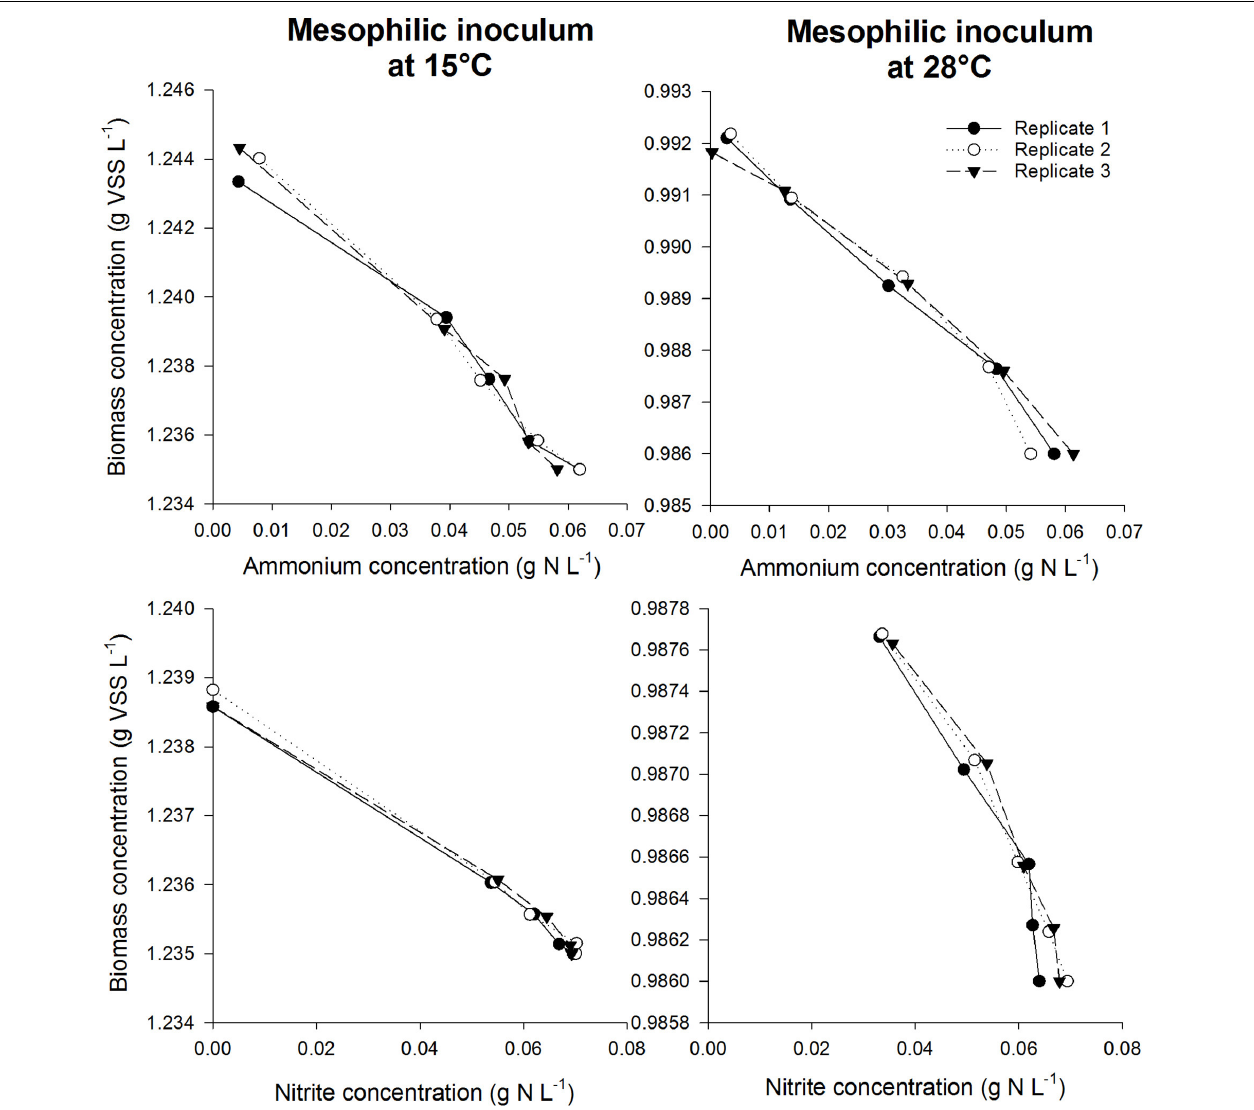
FIGURE 4 | Biomass concentration as a function of ammonium concentration (top) or nitrite concentration (bottom) during the incubations for the mesophilic inoculum at 15 ◦ C (left) and 28 ◦ C (right). The slope was used to determine the biomass yield for NOB in case nitrite was added as substrate, whereas the total AOB and NOB yield was obtained using the slope in case ammonium was added as substrate. By subtracting the NOB yield from the total yield, the AOB yield could be